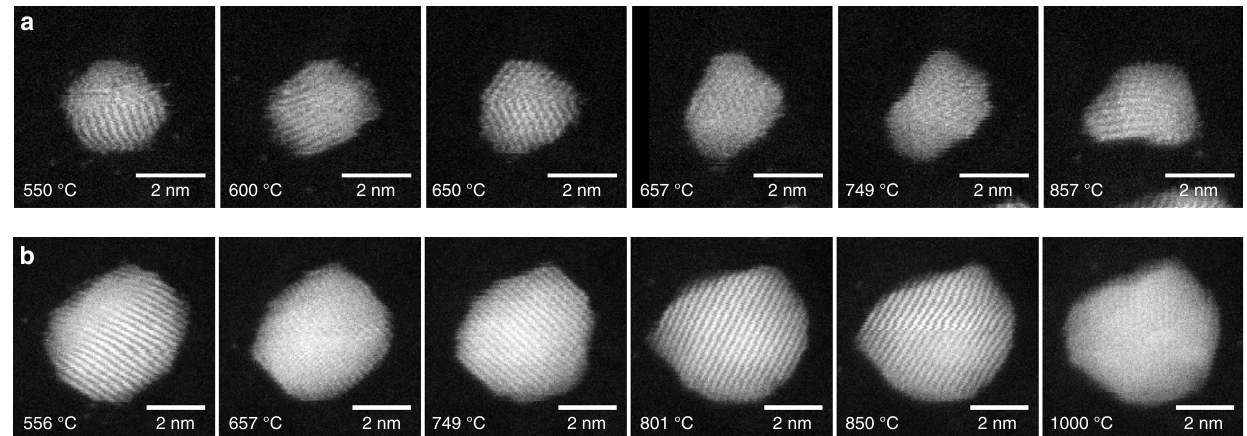
Fig. 1 Shape changes in Au nanoclusters at high temperatures. HAADF STEM images of a an individual Au 561 particle at high temperature (550 – 857 °C) and b an individual Au 2530 particle (556 – 1000